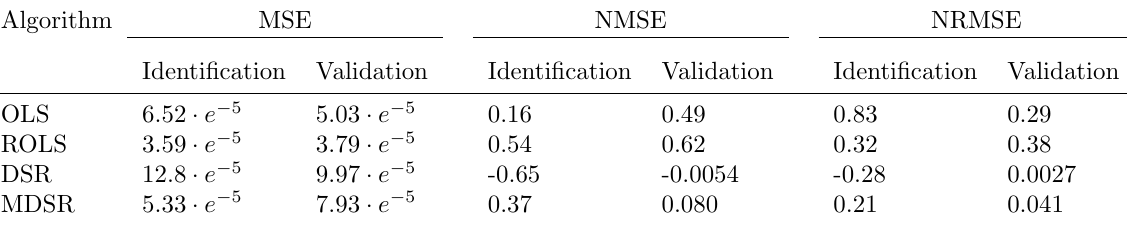
Table 4: Numerical validation of the models